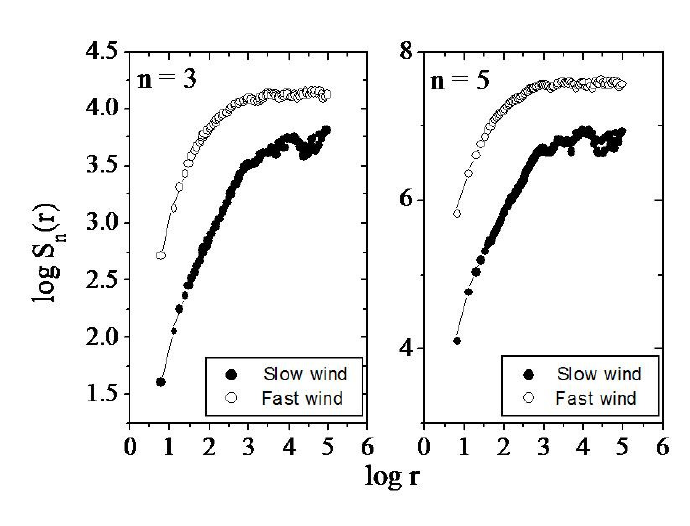
Figure 80: Structure functions for the magnetic field intensity 𝑆 𝑛 ( 𝑟 ) for two different orders, 𝑛 = 3 and 𝑛 = 5, for both slow wind and fast wind, as a function of the time scale 𝑟 . Data come from Helios 2 spacecraft at 0.9